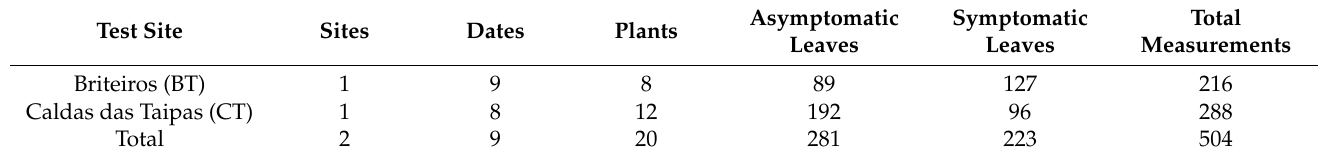
Table 4. Number of observations (leaves and plants) per test site and